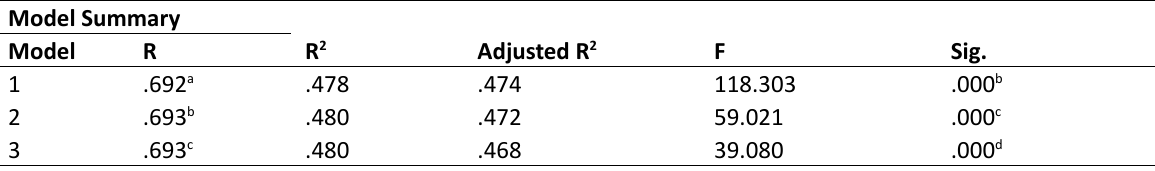
Table 2. Step-wise regression showing the influence of existing resources, facilitators, and trainee attitude upon the acquisition of university